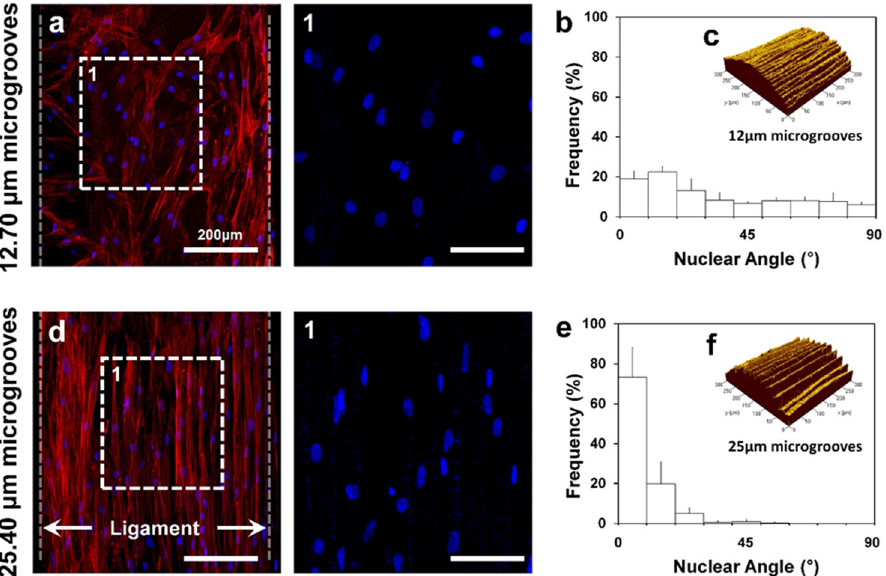
Figure 3. Cell orientation controls using different micro-groove intervals with 12.70 μ m and 25.40 μ m distance between grooves. After culturing human PDL cells for seven days, ( a – c ) 12.70 μ m micro-groove intervals randomly organized cells but ( d – f ) 25.40 μ m interval substrate guided highly aligned cells. Adapted with permission from the reference [8].